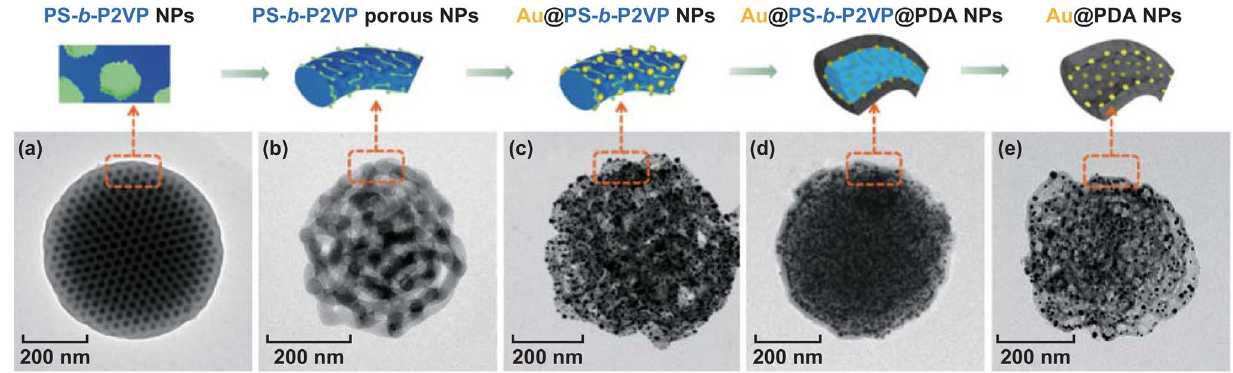
Fig. 1 TEM images of a PS‑ b ‑P2VP particle with ordered microphase‑separation structure; the dark dots present the I 2 ‑stained P2VP domains, b porous PS‑ b ‑P2VP particles derived from selective swelling, c Au@PS‑ b ‑P2VP particle, d Au @PS‑ b ‑P2VP@PDA particle, and e Au@PDA particle with multi‑compartment structure after removal of the PS‑ b ‑P2VP